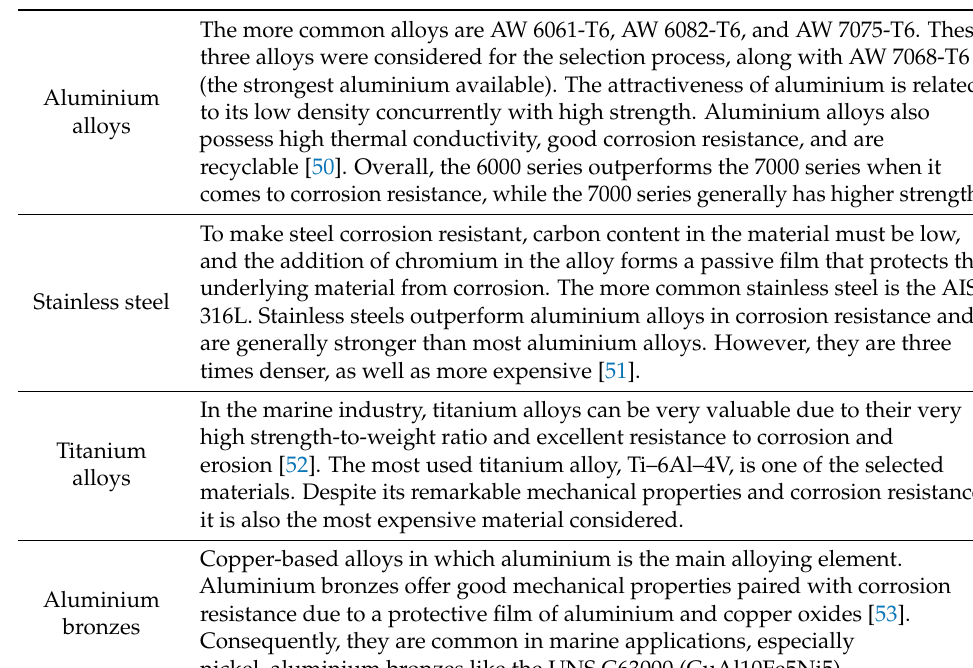
Table 3. Screened metals for the material selection process of the